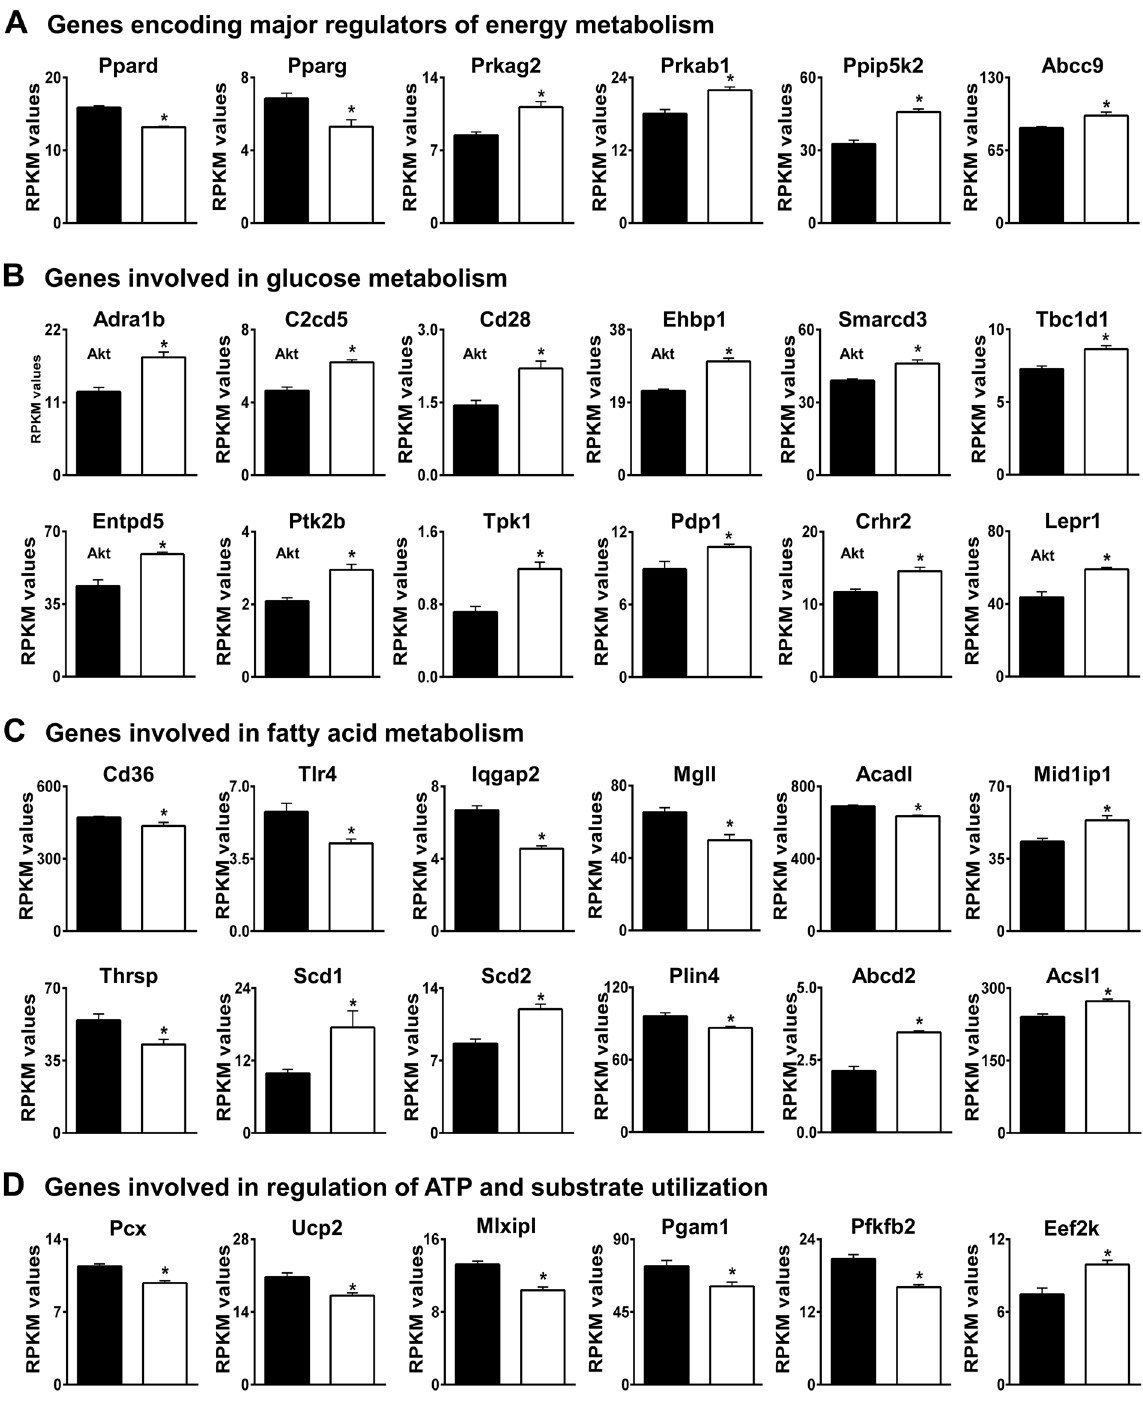
Figure 3. Differential expression of genes involved in energy metabolism. Genes encoding proteins that function in ( A ) regulation of energy metabolism, ( B ) glucose metabolism, ( C ) fatty acid metabolism, and ( D ) regulation of ATP and substrate utilization were identified by Gene Ontology analyses and/or by PubMatrix analyses of genes with an FDR < 0.05. RPKM values for WT (black bars) and AE3-null (white bars) hearts are shown. Genes encoding proteins that are regulated by Akt are indicated (Akt). The genes shown are a subset of 142 genes in Supplementary Table S4; values are means ± SE; n = 4 for each genotype; * p ≤ 0.01 vs WT